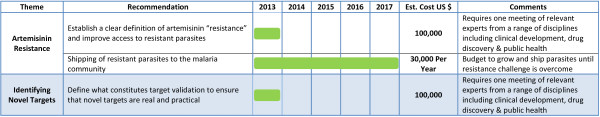
Action plan to deliver “quick wins”. The estimates of costs and timing needed to deliver the prioritized recommendations classified as “quick wins”.